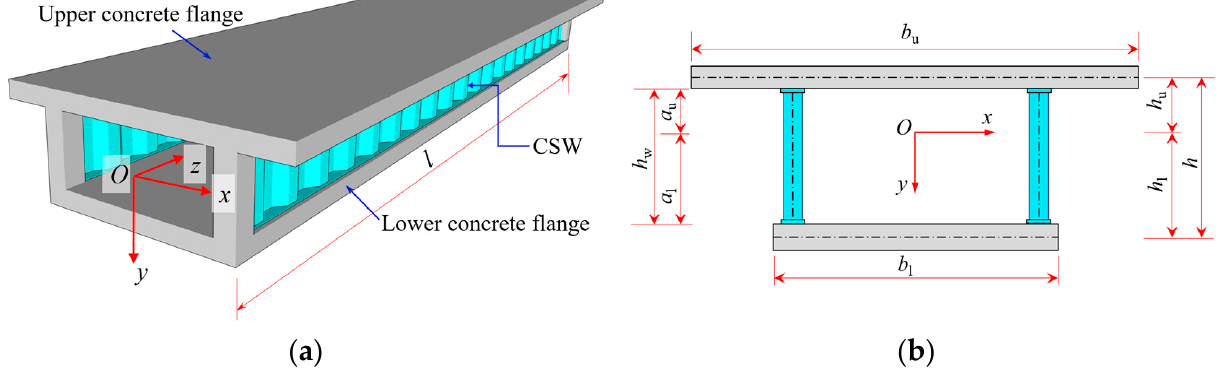
Figure 1. A typical CBG-CSWs modal: ( a ) coordinate system; ( b ) cross-section. When subjected to vertical load, the CBG-CSWs will have bending deformation, as shown in Figure 2. If w is used to represent the vertical deflection, then according to assumption (2) the deflection angles of the upper and lower flanges of the CBG-CSWs are both w (cid:48) ( z ). The angle around the x -axis of the line between the centers of the upper and lower flanges is θ ( z ), and the angle around the x -axis of the line between the top edge and the bottom of the CSWs is α ( z ). Under the combined influence of CSWs’ folding effect and shear deformation, the angles w (cid:48) ( z ), θ ( z ) and α ( z ) are not equal [11,13]. According to Figures 1 and 2, the longitudinal bending displacements u u ( y , z ) and u l ( y , z ) at any point of the upper and lower flanges can be respectively expressed as: